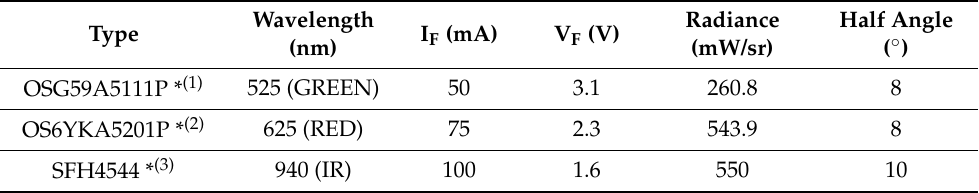
Table 2. Selected technical parameters of the power supply [29] . Type of Power Supply Used